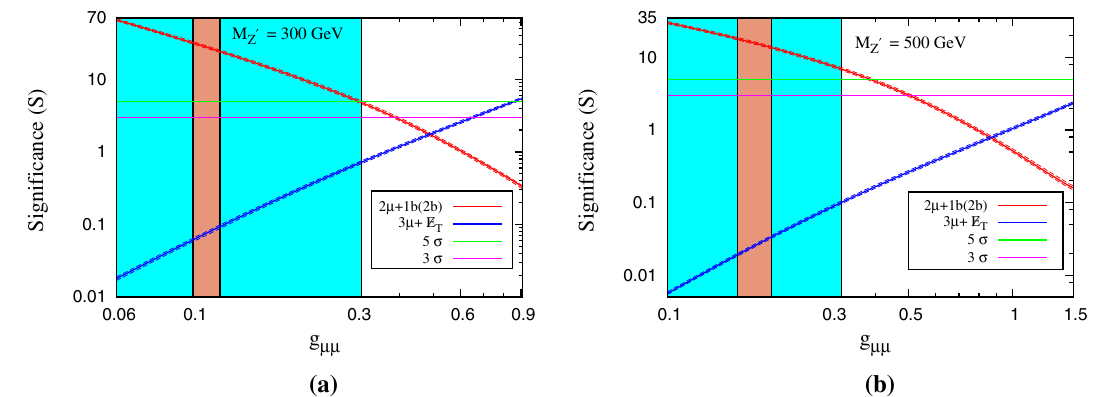
Fig. 13 The parameter range of our model excluded at 95% CL by the 2 μ + 1 b ( 2 b ) (red) and 3 μ + E T / (blue) channels for the same col- √ s = 13 TeV with the ATLAS dimuon resonance search [74,75] at lision energy and luminosity. The brown region is preferred at 1 σ CL by combining the constraints from b → s (cid:2)(cid:2) anomalies, the neutrino 139 fb − 1 (light blue band) for M Z (cid:2) = 300 GeV (13a) and M Z (cid:2) = 500 trident production, and B → D ∗ (cid:2)ν GeV (13b). This is compared with the signal significance expected in